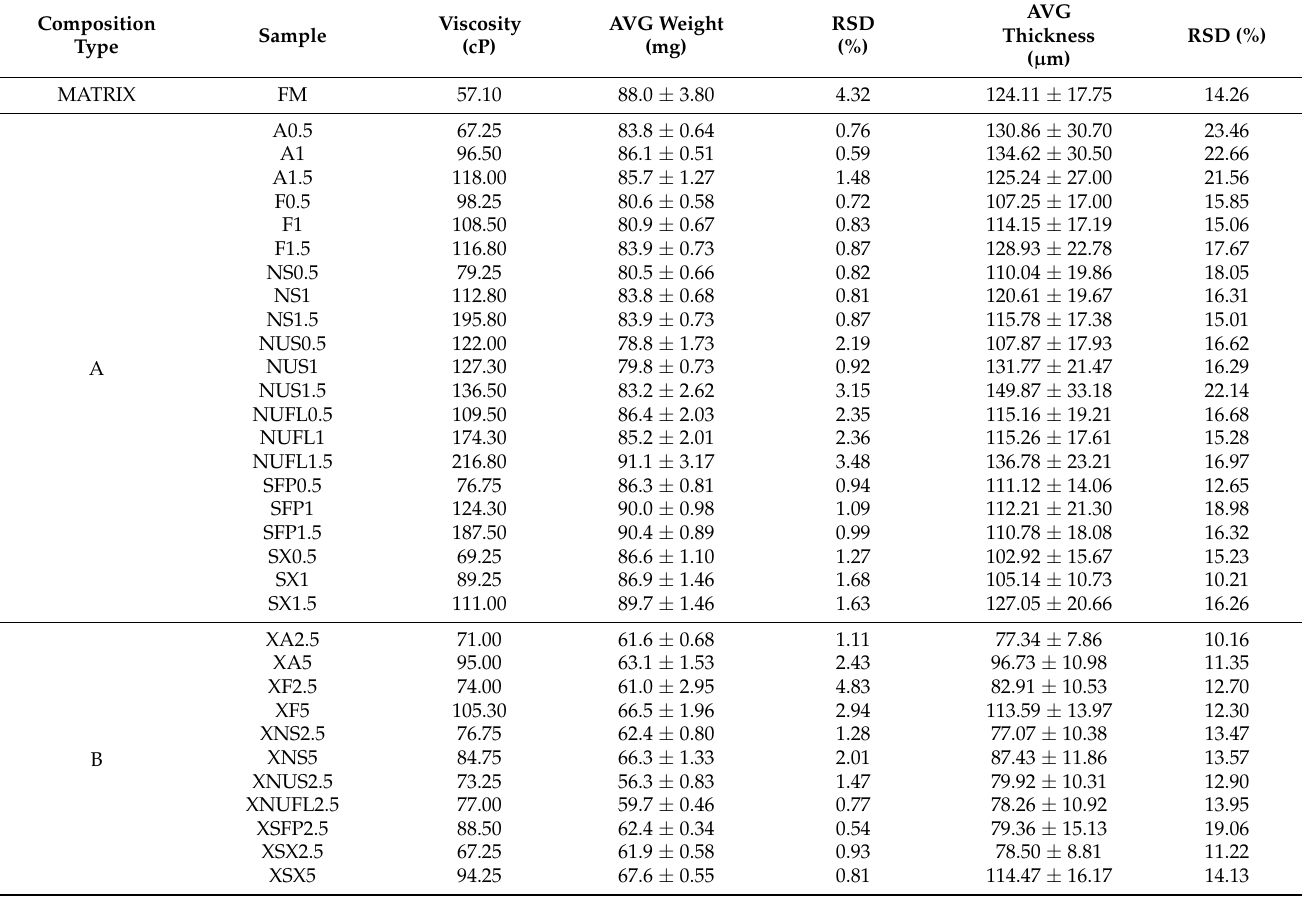
Table 2. Viscosity of print dispersions and measurements of the weight and thickness of